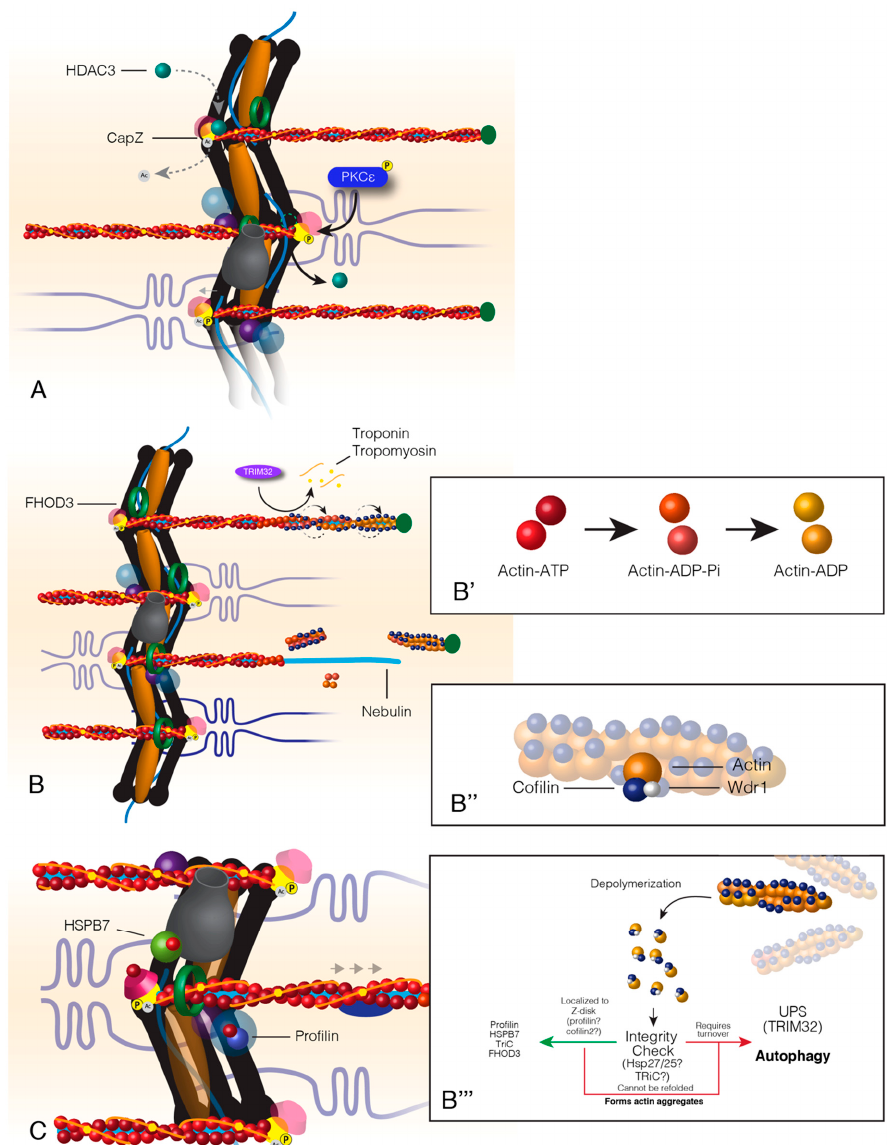
Figure 3. Turnover of actin within sarcomere thin filaments. Actin turnover begins with the relaxation of CapZ-thin filament binding at the Z-disc ( A ). This relaxation occurs from the competition between HDAC3 and PKC ε . HDAC3 acetylates CapZ, which promotes a tight bond between CapZ and actin. PKC ε phosphorylates CapZ that causes HDAC3 to disassociate from the Z-disc and CapZ to loosely bind the thin filaments. Following CapZ relaxation, FHOD3 encompasses the thin filaments, and actin-binding proteins associate with actin at the distal end of the thin filament ( B ). Actin at the distal end of the thin filaments is “aged” by the associated state of ATP, ADP+Pi or ADP (B’). Actin-binding proteins, Cofilin and Wdr1, bind “aged” actin, twist and break it away from the filament ( B & B’’ ). Cofilin breaks filamentous actin into monomeric actin that is escorted back to the Z-disc where it is recycled back into the thin filaments ( B”’ ). Hypothetically, actin should pass through an “integrity check” as most sarcomere proteins do. The outcomes of this check would result in recycling back into the thin filament or targeted degradation ( B”’ ). Healthy actin monomers (G-actin) are reincorporated into the thin filament by Z-disc localized factors profilin, formin, and HSPB7; a process that maintains the oldest actin within the sarcomere A-band or the distal portion of the thin filament ( C